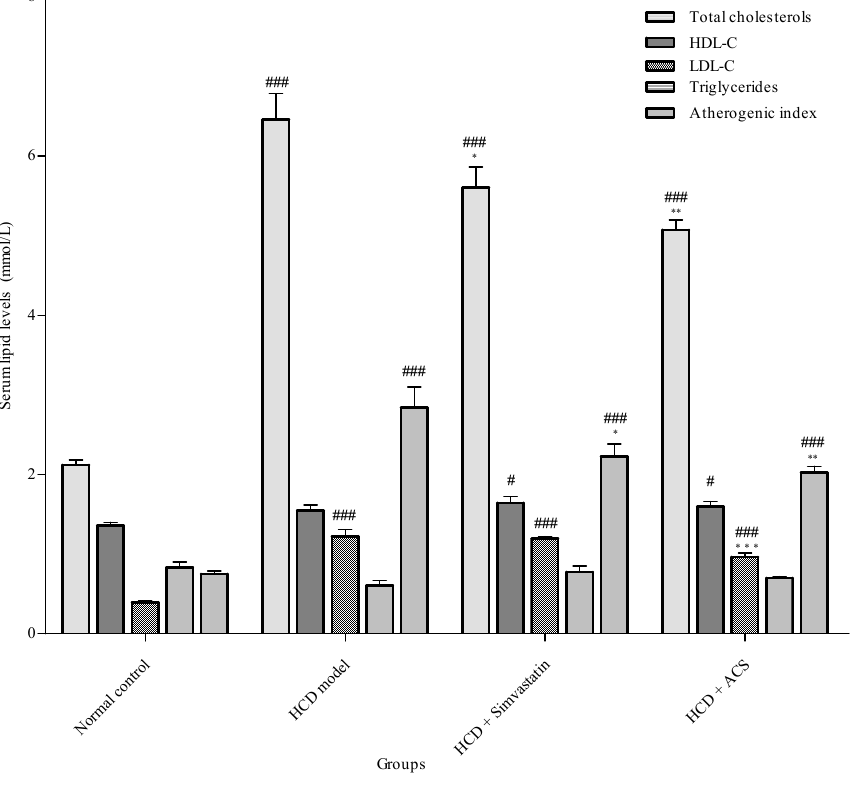
Figure 4. Serum lipid levels and atherogenic indexes of rats. Data are expressed as means ± SEM, ( n = 5–7). One-way analysis of variance (ANOVA), Tukey HSD post hoc test. # p < 0.05 and ### p < 0.001 represent significant differences when compared with the normal control group. * p < 0.05, ** p < 0.01, and *** p < 0.001 represent significant differences when compared with the high cholesterol diet (HCD) group.